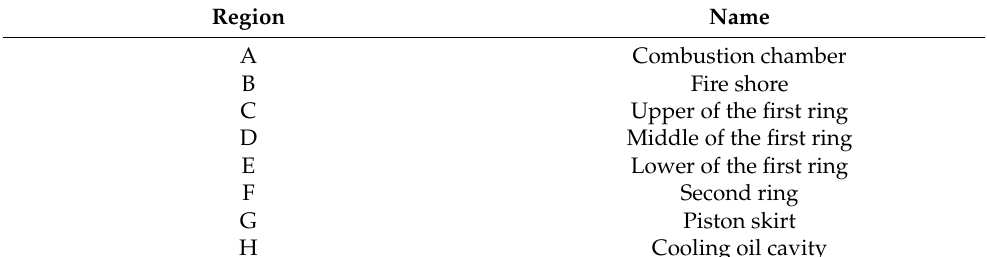
Table 1. The name of each region.